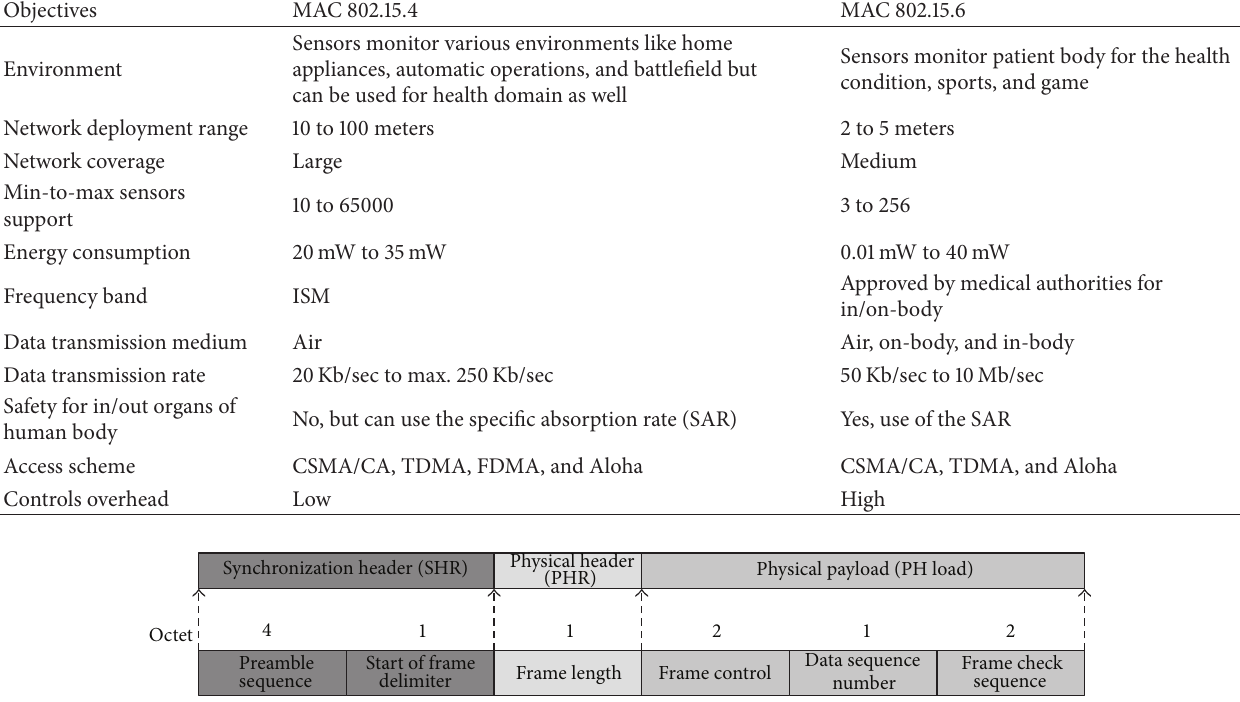
Figure 8: IEEE 802.15.4 physical frame structure (redrawn from